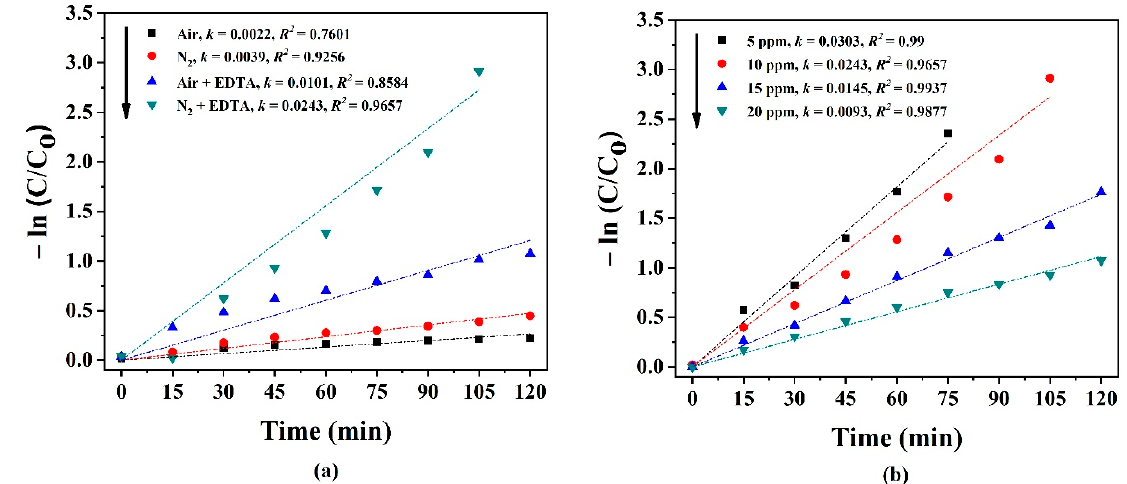
Figure 13. ( a ) Graph of – ln ( C / C o ) vs. time and the reduction reaction rate constants for TNTs annealed in air and nitrogen with and without EDTA. ( b ) Graph of – ln ( C / C o ) for reduction of Cr(VI) in various initial concentrations. Both experiments were conducted by sunlight irradiation for a Cr(VI) solution with a pH level of 1. Table 2. Comparison of obtained Cr(VI) reduction efficiency with recent studies under UV–Vis light irradiation (RGO = reduced graphene oxide; C = carbon; N 2 = nitrogen).